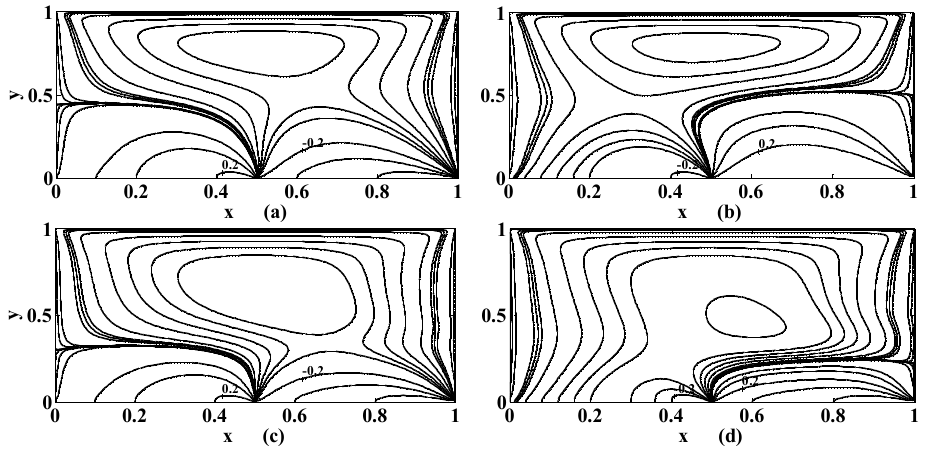
(cid:110) (cid:111) = S t , α p when ( a )